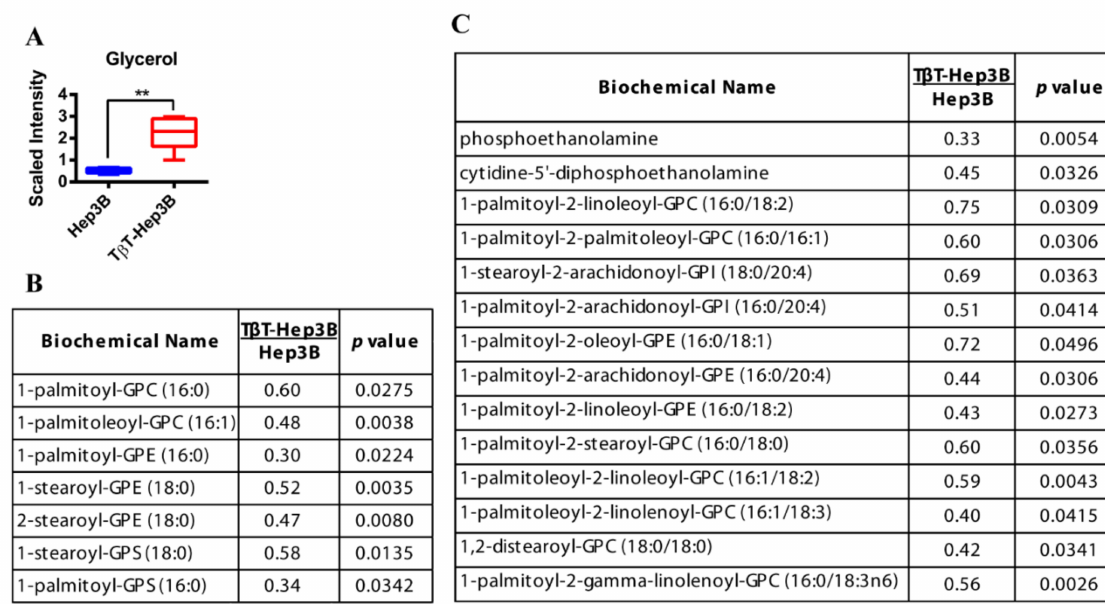
Figure 2. Increased glycerol levels and decreased lysolipids and phospholipids in T β T-Hep3B cells. ( A ) Level of glycerol is depicted by a box plot with whiskers (min to max). Welch’s two-sample t -test was used to identify biochemicals that differed significantly between experimental groups ( n = 5 for each group). ** p < 0.01. ( B , C ) Levels of lysolipids ( B ) and phospholipids ( C ) of T β T-Hep3 compared to Hep3B presented in fold. Welch’s two-sample t -test was used to identify biochemicals that differed significantly between experimental groups ( n = 5 for each group, p -value indicated in the right